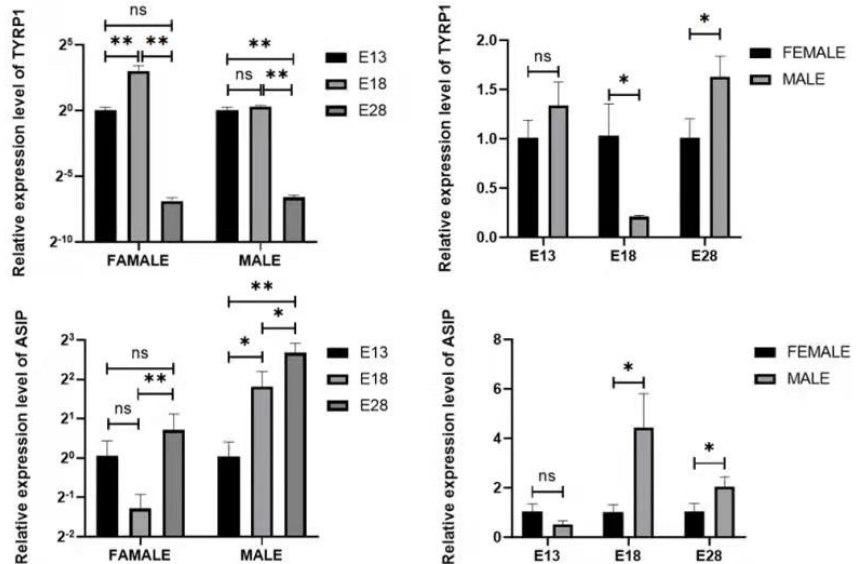
Figure 7. The expression of TYRP1 and ASIP genes in Holdobaggy geese dorsal skin feather follicles during embryonic stage. Note: ns no significant difference ( p > 0.05), * Significant difference ( p < 0.05), ** extremely significant difference ( p < 0.01). The results are expressed as the mean ± SEM. n:3.